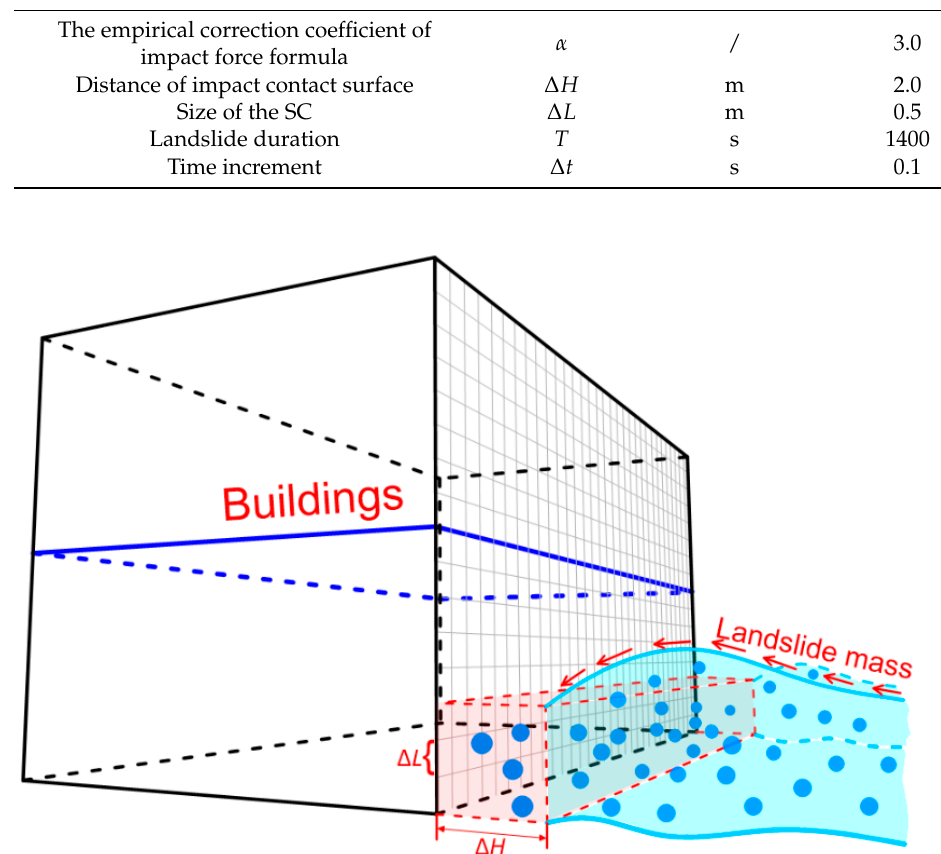
Figure 13. Schematic illustration for the impact force of the landslide mass model.